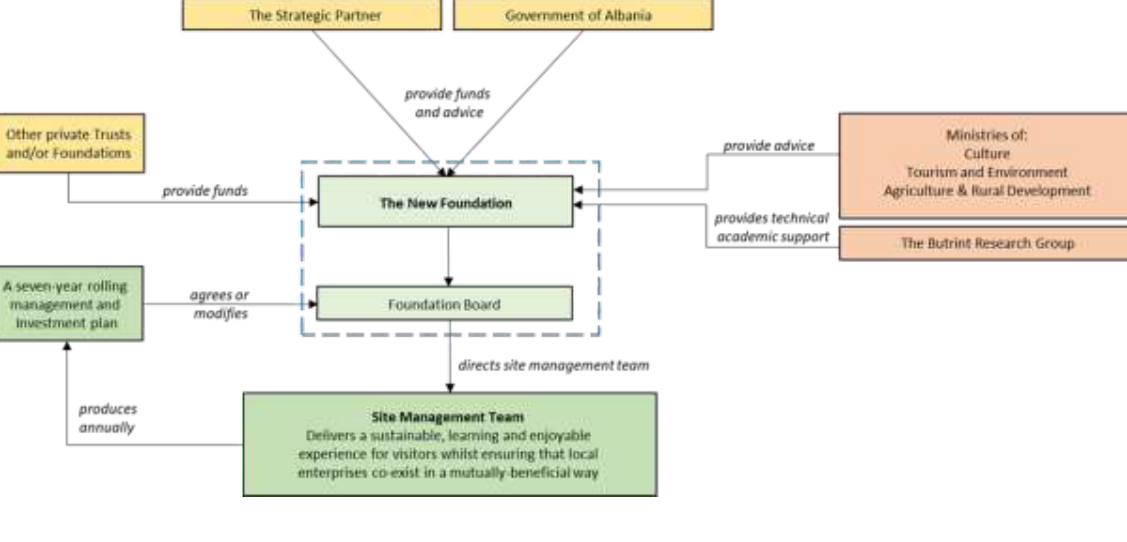
Figure 19: The New Foundation - headline